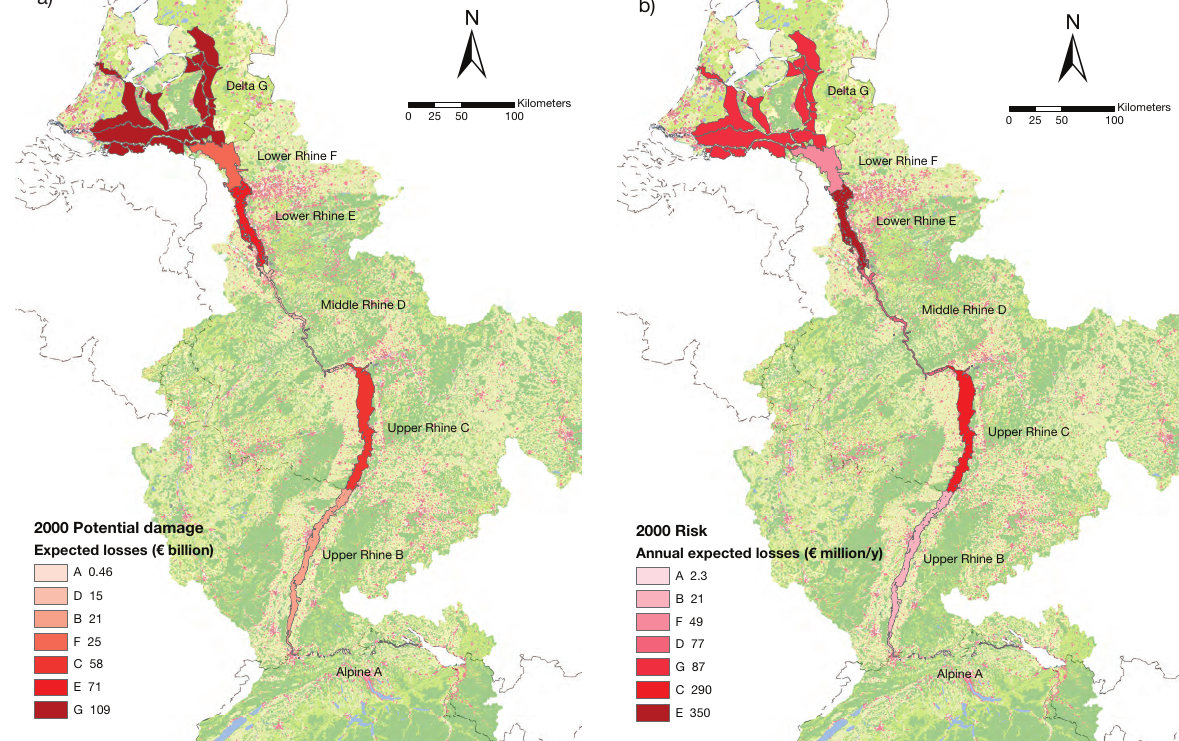
Fig. 5. Potential damage (a) and flood risk (b) , aggregated to seven regions along the Rhine.